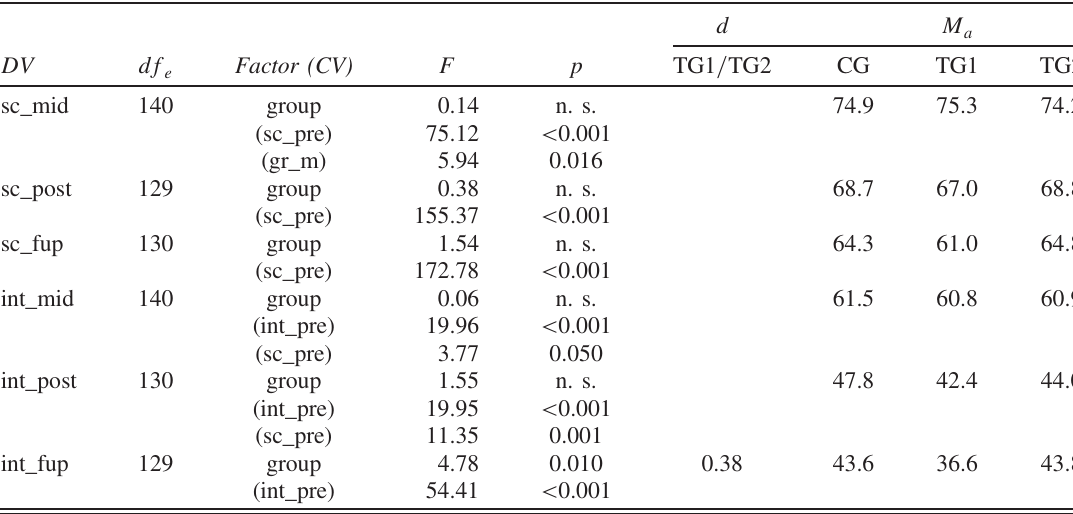
TABLE VI. ANCOVA of the self-concept and the interest variables at midintervention, postintervention, and follow-up. Dependent variable ( DV ); Error degrees of freedom ( df ); F statistic ( F ); observed significance level e ( p ); effect size Cohen d ð d Þ ; adjusted means ( M ) (abbreviations: sc_mid: midintervention self-concept; int_pre: a pre-intervention interest, gr_m: prior grade in